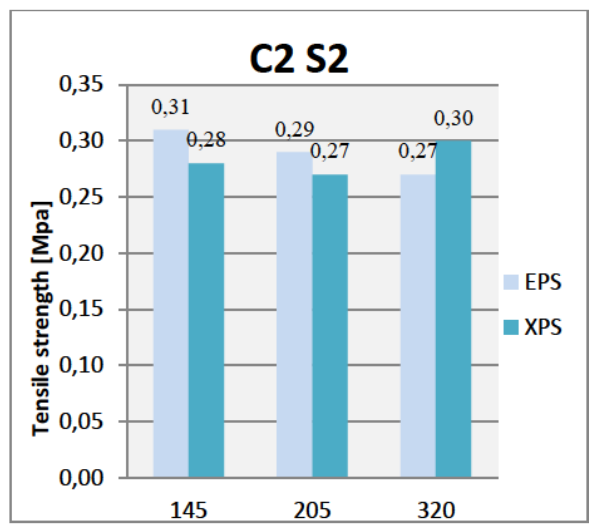
Figure 11: Average results of the shear strength tests; comparing